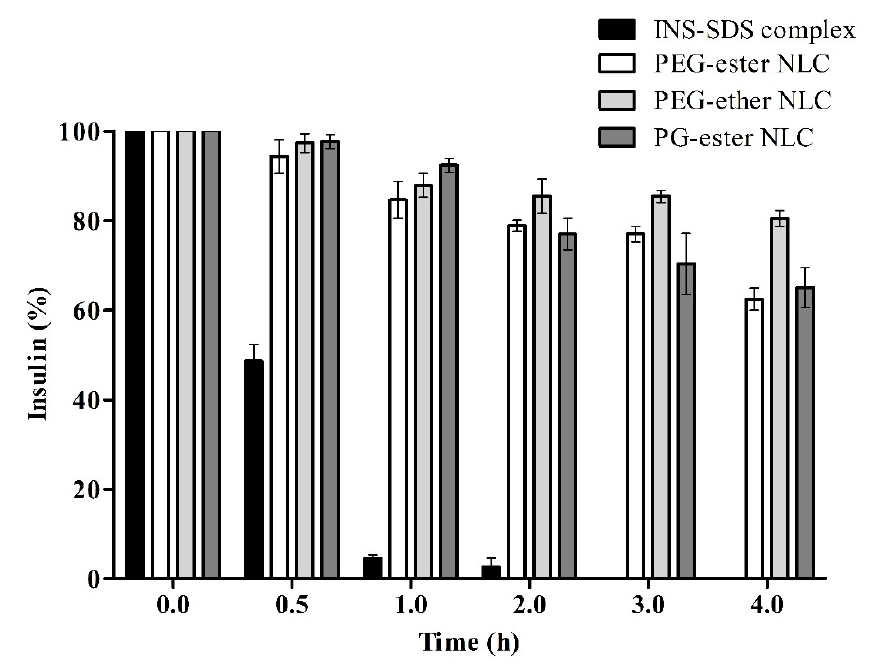
Figure 5. Remaining percentage of intact insulin in indicated formulations compared to the unformu- lated INS-SDS complex during degradation in SGF at 37 ◦ C and pH 1.2. At each time point, pepsin activity in withdrawn aliquots was quenched by the addition of 0.002 M NaOH. Data are shown as means ± SD ( n = 3).